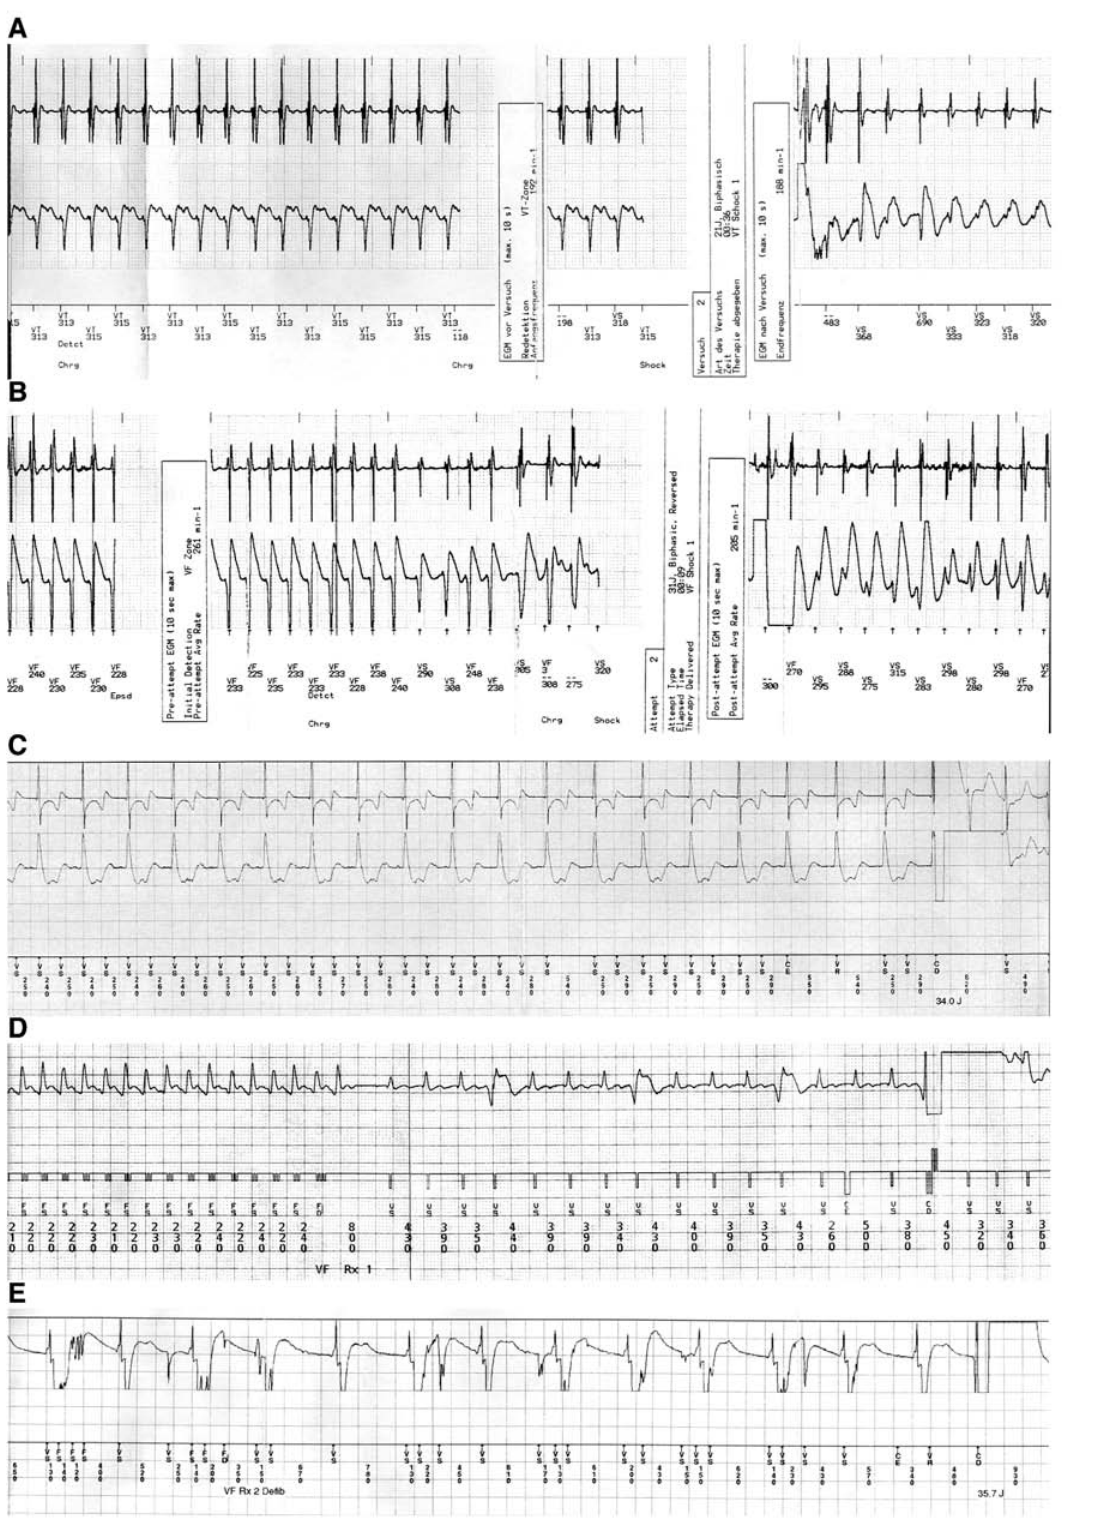
Figure 3 Several causes of inappropriate interventions: A: Sinus tachycardia at a rate of 190/min during a soccer game triggering inappropriate shock in a 19 y.o. patient with Fallot tetralogy who had had ICD implantation because of recurrent monomorphic VT at a rate of 190/min. Because of the progressive rate acceleration, the tachycardia was recognised as sinus tachycardia by the ICD, and therapy was initially inhibited. However, there was a time-out period of 3 minutes for treatment inhibition and therapy was resumed after 3 minutes as sinus tachycardia persisted. Treatment inhibition time-out period was subsequently increased to 15 minutes. B: Rapid atrial fibrillation with slightly irregular rhythm (RR intervals between 233 and 308 msec detected in the ventricular fibrillation (VF) zone, triggering high-energy shock. The shock fails to convert atrial fibrillation which was responsible for repeated shocks. Changes in the detection enhancement parameters (changes in RR stability cut-off) in a newly programmed ventricular tachycardia zone may allow preventing the inappropriate ICD intervention, but in this case, anti-arrhythmic drug therapy was necessary to slow atrial fibrillation and deemed safer to avoid further inappropriate ICD shocks. C: T wave oversensing with double-counting and inappropriate detection in the ventricu- lar tachycardia zone leading to a 34 Joule-shock (subsequent to unsuccessful overdrive pacing attempts, not shown). The problem could be solved by decreasing the sensitivity (sensing threshold at 0.6 mV instead of 0.3 mV). In some other situations, the ICD lead needs to be repositioned or changed. D: Non-sustained, rapid ventricular tachycardia (cycle length 230 msec) detected by the ICD just before spontaneous termination. ICDs of the new gen- eration perform redetection of the arrhythmia at the end of the charging time (CE) before energy delivery (CD), which may prevent inappropriate ICD intervention in this situation. Anti-arrhythmic drug therapy preventing longer VT runs or prolongation of the VT detection time can also efficiently prevent further inappropriate ICD interventions. E: Lead rupture with electrical artefacts (noise) detected in the ventricular fibrillation zone, responsible for repeated high-energy shocks. A new ICD lead was